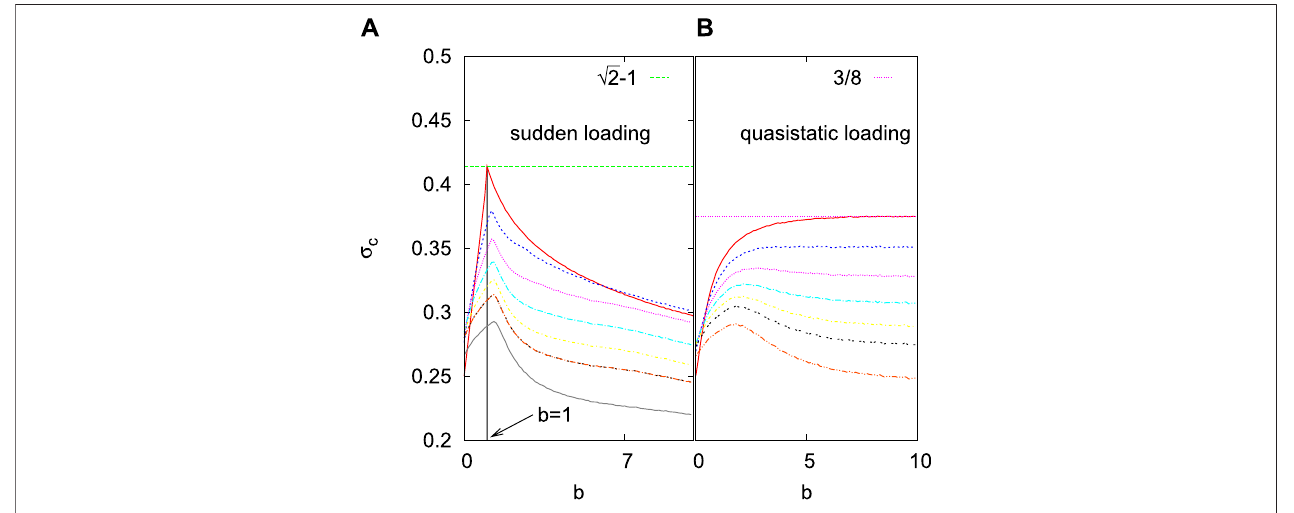
FIGURE13| Thephasediagraminthe b − σ c plane( b representstheanisotropyintheloadredistributionprocess)isshownfor(a)discretestepand(b)quasi-static loading for various fractional errors in the knowledge of the threshold values of the individual fi bers (curves from top to below are for e (cid:1) 0 . 0 , 0 . 1 , 0 . 2 , 0 . 3 , 0 . 4 , 0 . 5 , 0 . 75). The upper bounds for both cases are shown, which are reached for b (cid:1) 1 (a) and b → ∞ (b). From [51].